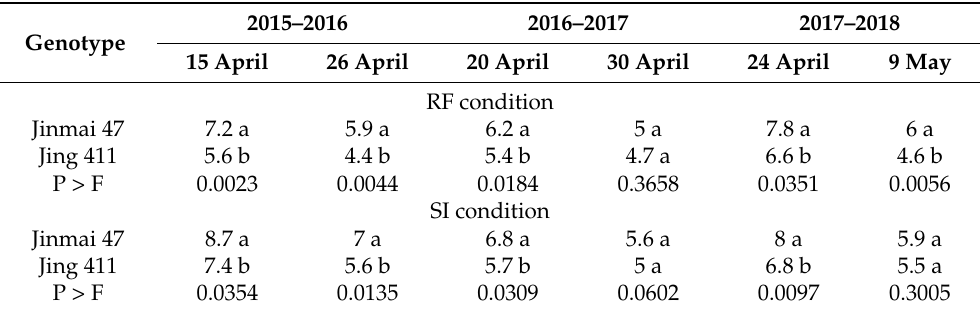
Table 4. Canopy temperature depression (CTD, ◦ C) of the genotypes Jinmai 47 and Jing 411 under the rain-fed (RF) and supplemental irrigation (SI)